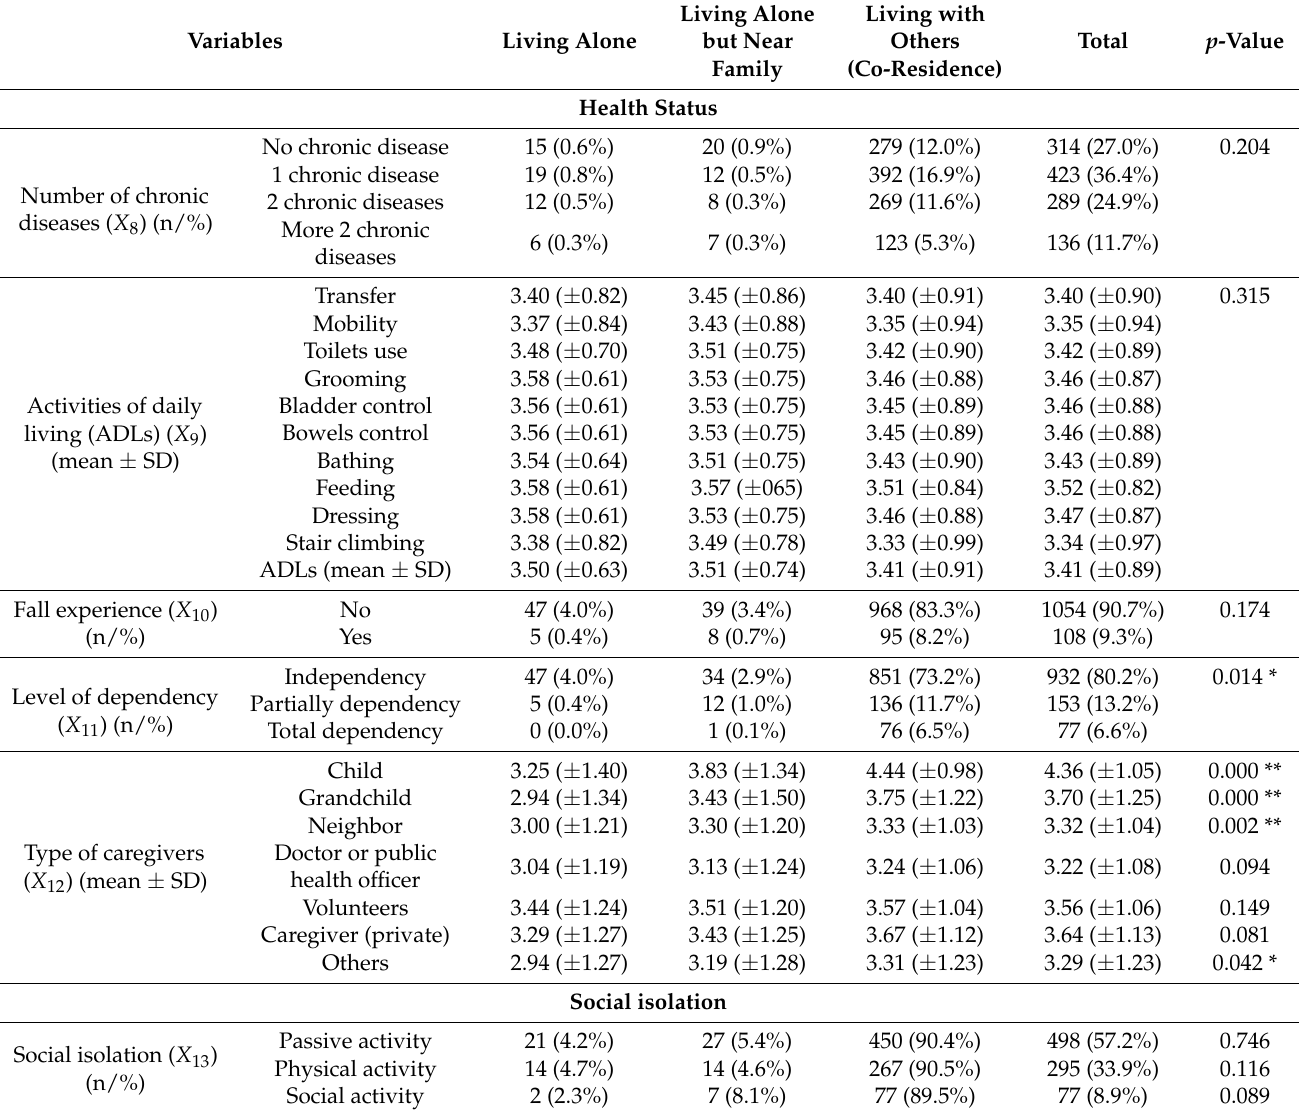
Table 3. Health status and social isolation of older